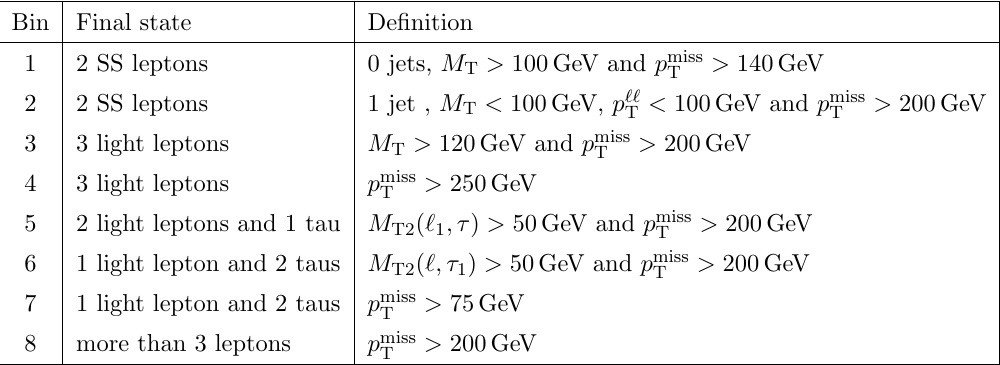
Table 9 . De(cid:12)nition of the aggregated regions for multilepton and two SS dilepton (cid:12)nal